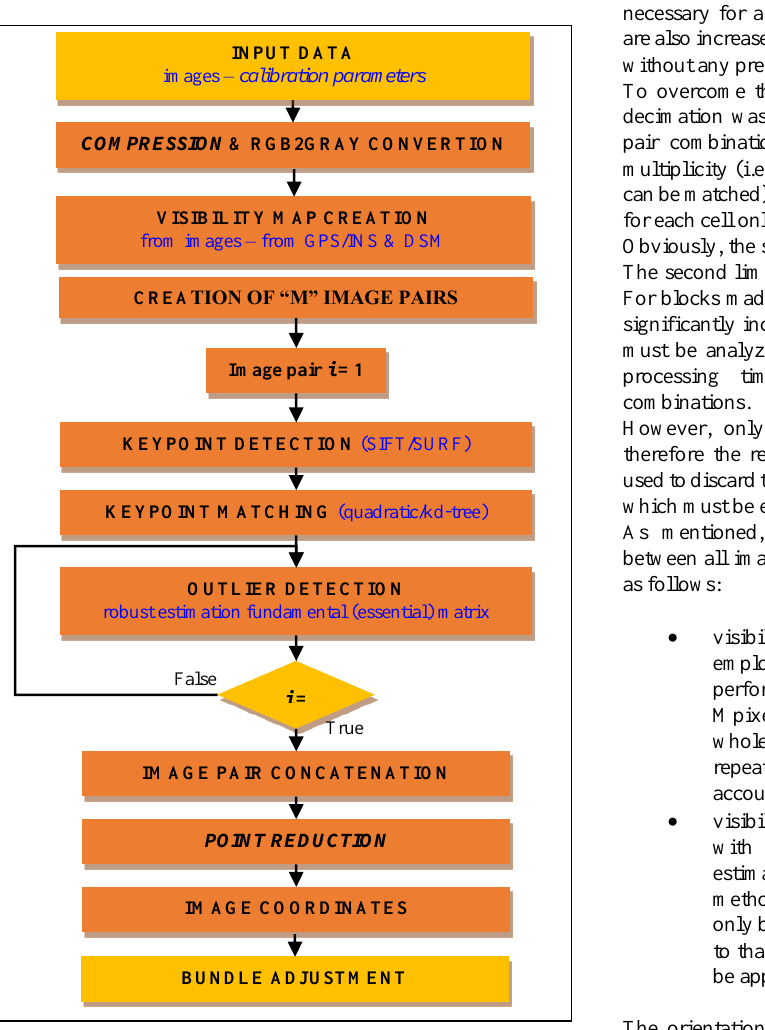
Fig. 4. The flowchart of the image orientation phase. The use of FBM techniques like SIFT and SURF for the detection blocks. A large variety of deformities, for instance scale good set of image points.